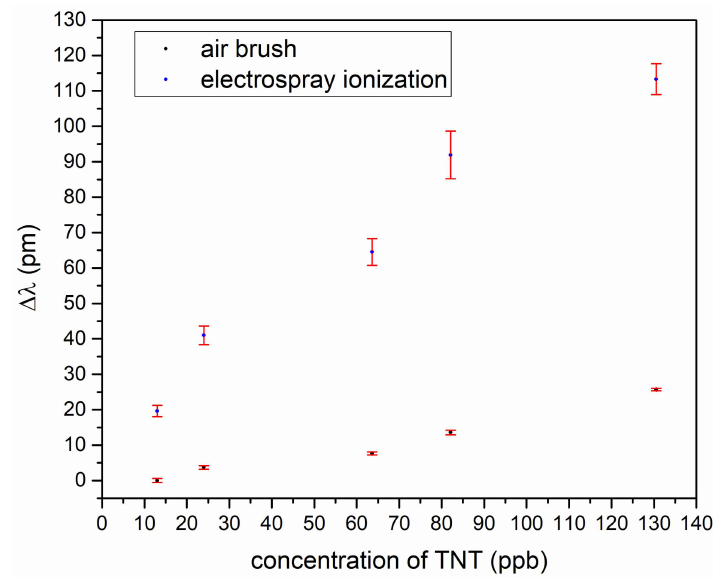
Figure 5. Shift of the resonant wavelength in dependence of trinitrotoluene (TNT) concentration. Blue: Chip was covered by air brush proceeding, black: Chip was covered by electrospray ionization.